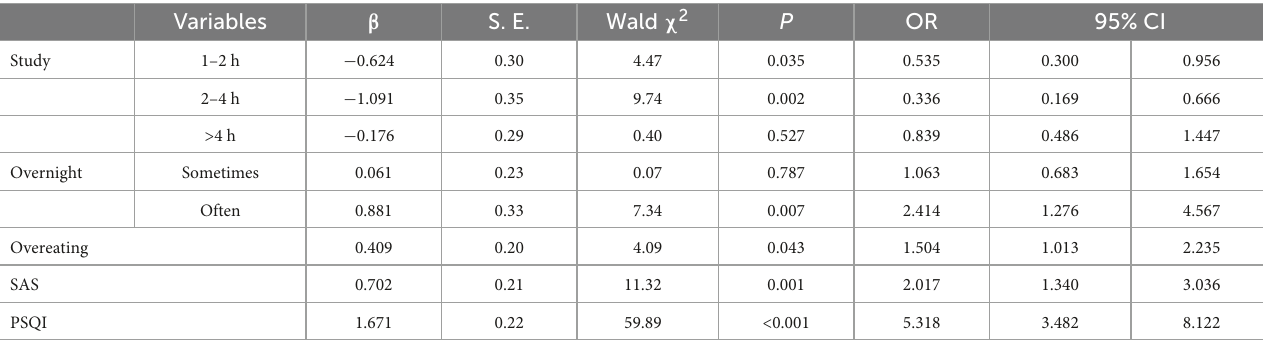
TABLE 4 Multi-factor logistic regression analysis of